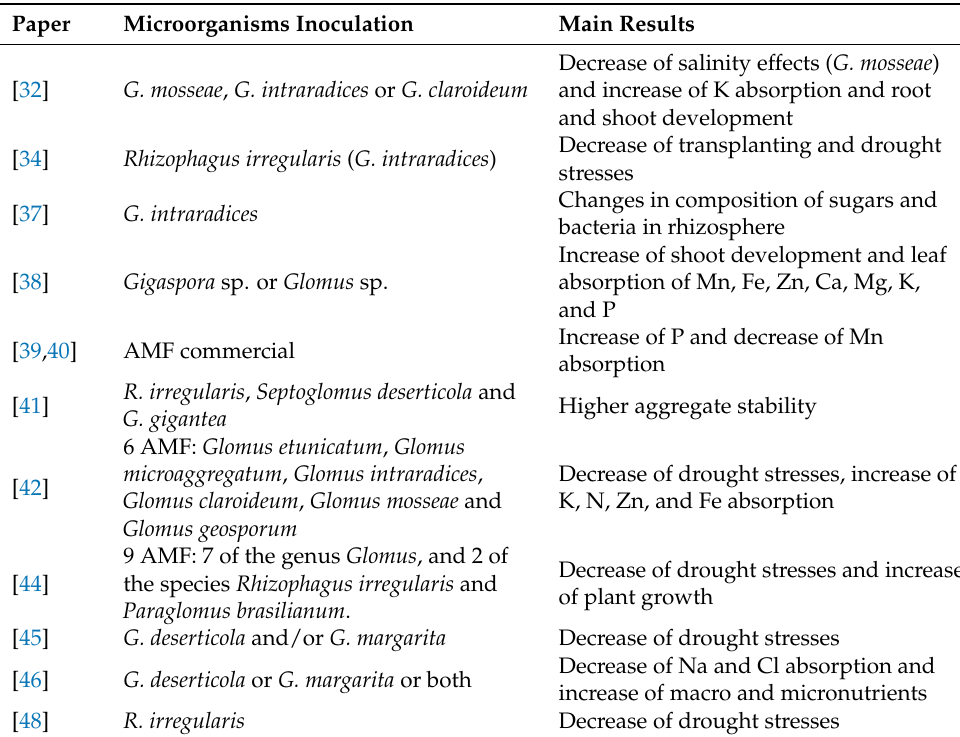
Table 1. Effects of microorganism inoculation on yield, absorption of nutrients, soil conditions, and resistance to drought in olive